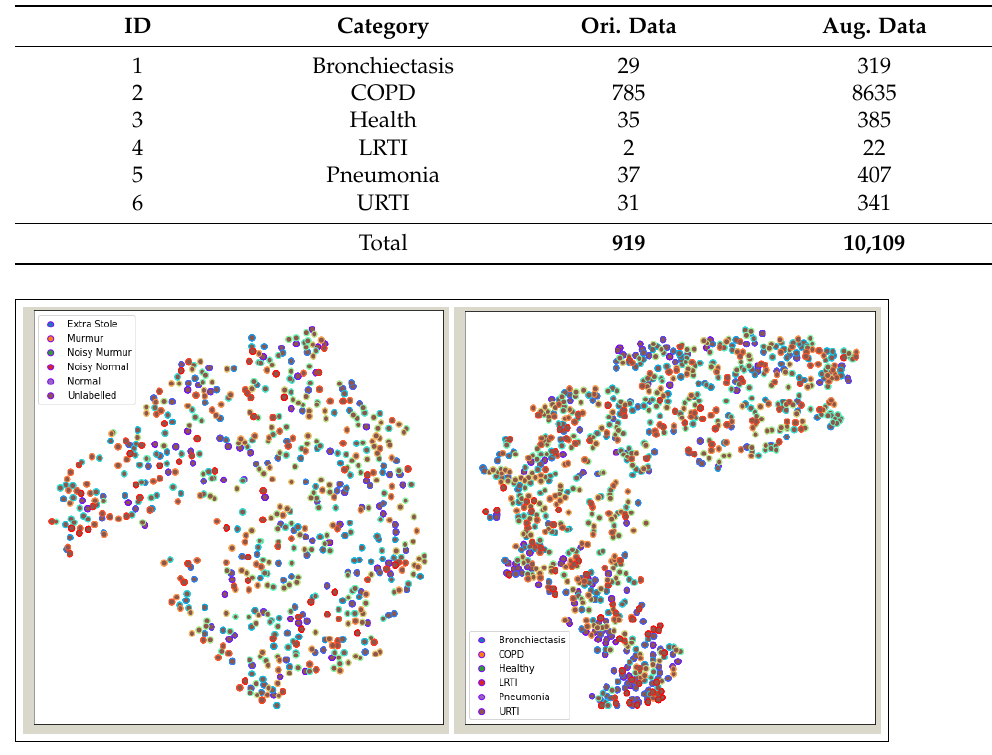
Figure 5. t-SNE Visualization: Heart Sound Dataset and Lung Sound Dataset.